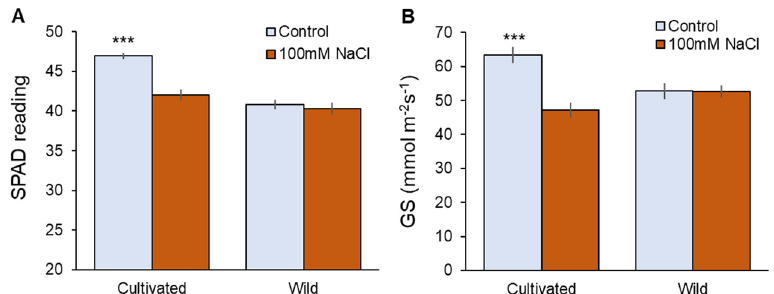
Figure 2. Physiological responses to two weeks of salinity (100 mM NaCl) treatment in cultivated and wild rice species. ( A ) SPAD value (chlorophyll content); ( B ) Gs (stomatal conductance). Asterisks indicate significant differences within the plant species (*** significant at p < 0.001, Student’s t -tests). Mean ± SE ( n = 10).